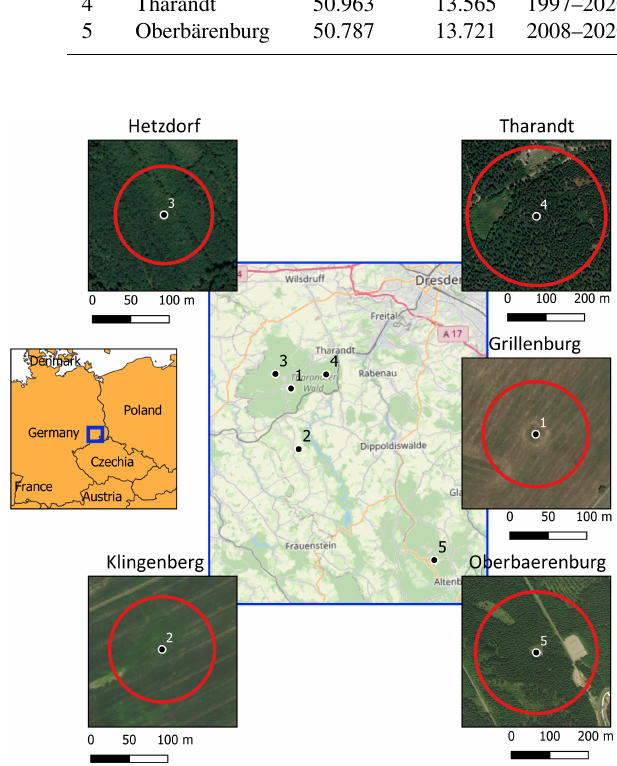
Figure 1. Location of chosen FLUXNET sites. Red circles rep- resent footprints for each tower. OpenStreetMap (planet dump re- trieved from https://planet.osm.org, last access: 20 November 2021) and Bing Satellite images (Bing Maps tiles, 2020) are used as a